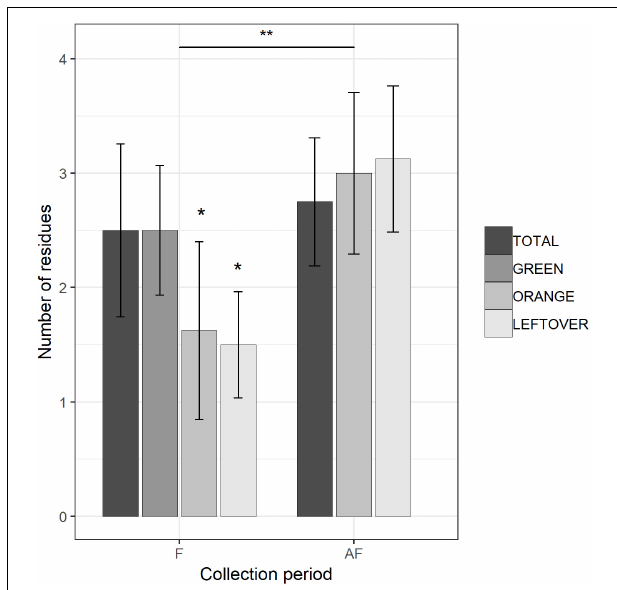
FIGURE 2 | Number of insecticide residues detected in each sample, during (F) and 2 weeks after the end of apple blossom (AF). Asterisks show statistical